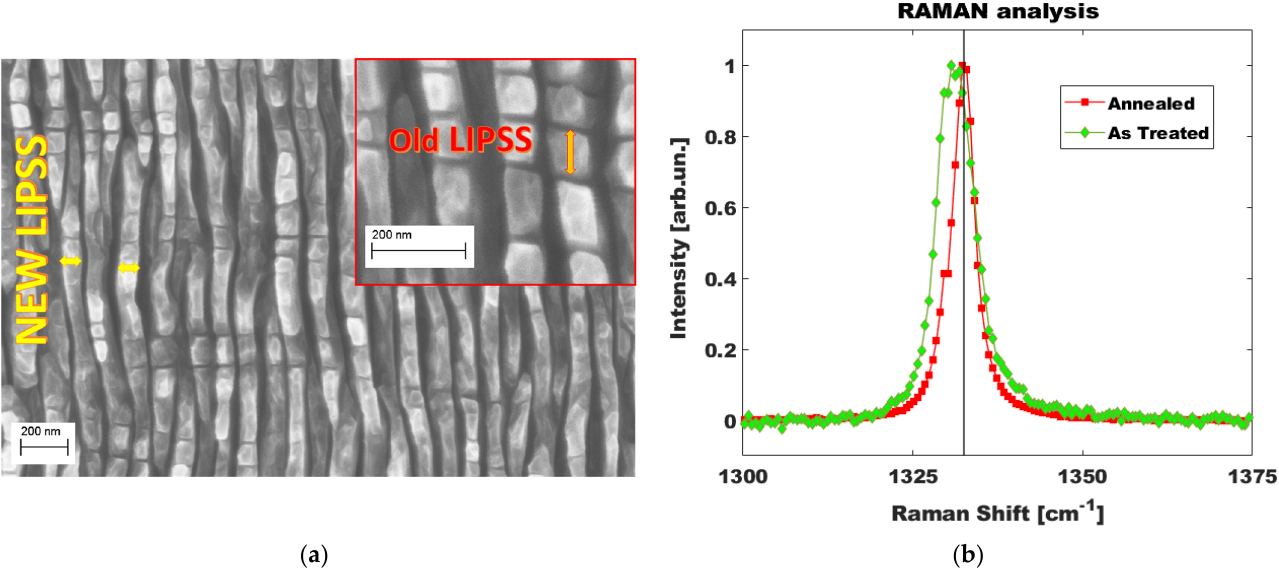
Figure 4. Surface characterization of black diamond samples ( a ) SEM image of the surface; ( b ) Raman analysis of the diamond peak at 1331.2 cm − 1 before (green curve) and after (red curve) of the annealing at temperature slightly higher than 500 ◦ C for more than 24 h. Black line corresponds to natural diamond Raman